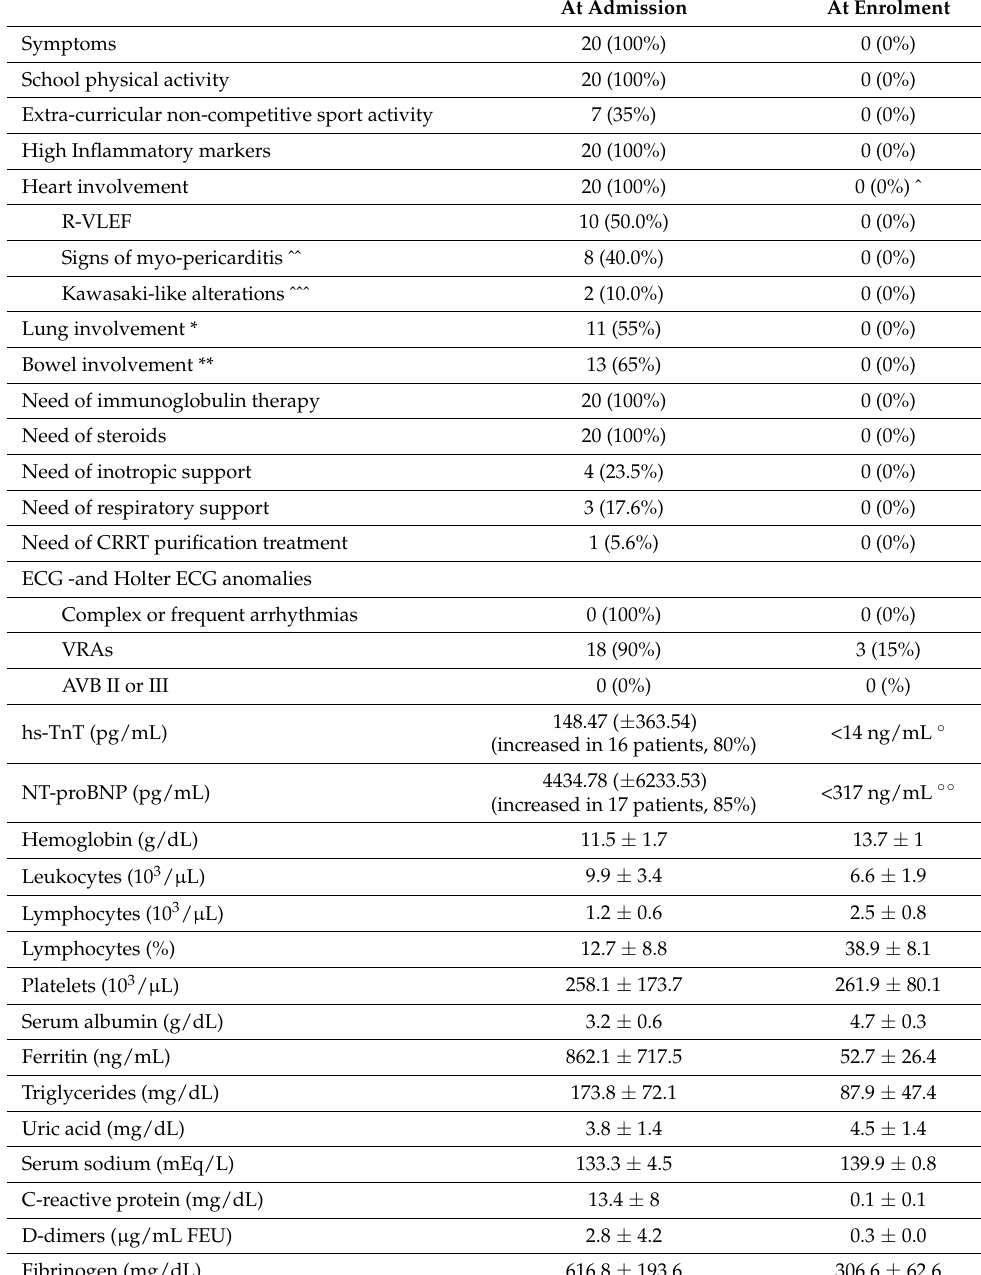
Table 2. The main clinical-instrumental and laboratory findings data at the time of admission and at